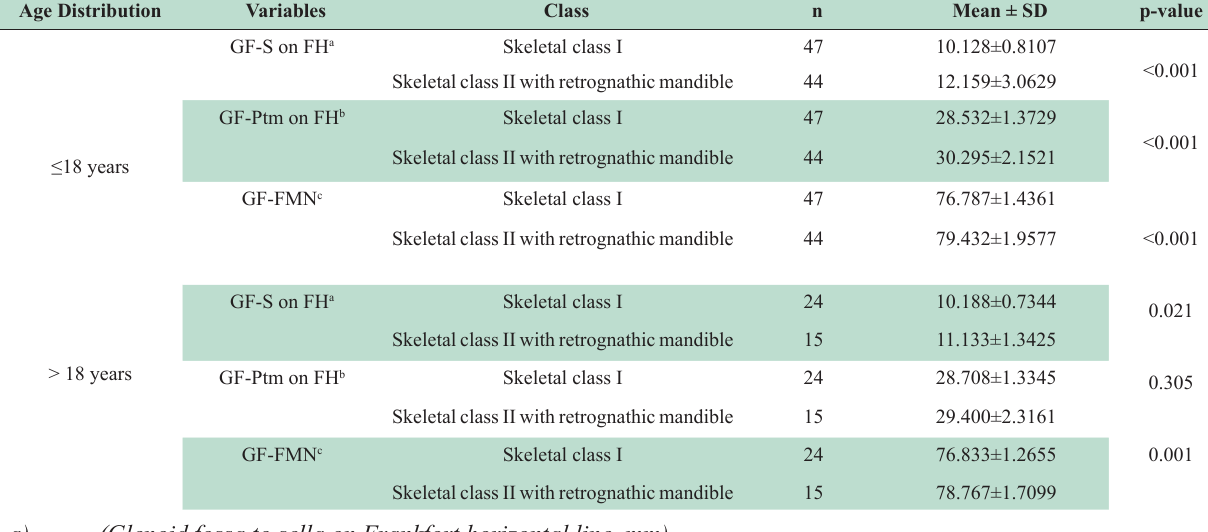
Table-III: Comparison of GF-S on FH, GF-Ptm on FH and GF-FMN in Skeletal class I and skeletal class II with retrognathic mandible in both age groups.